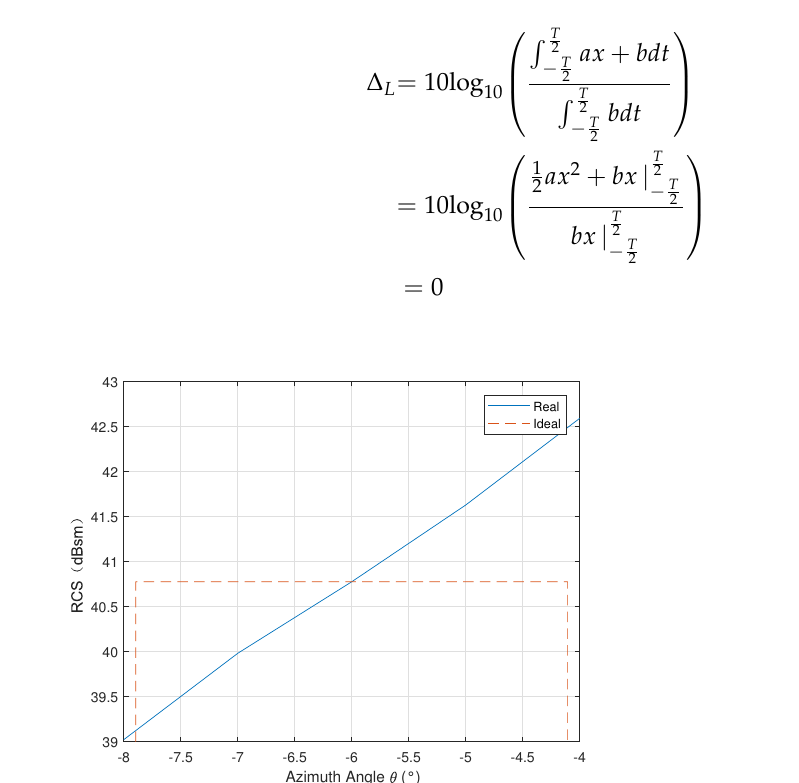
Figure 5. The partial azimuth RCS pattern in the case of misalignment ( θ = − 6 ◦